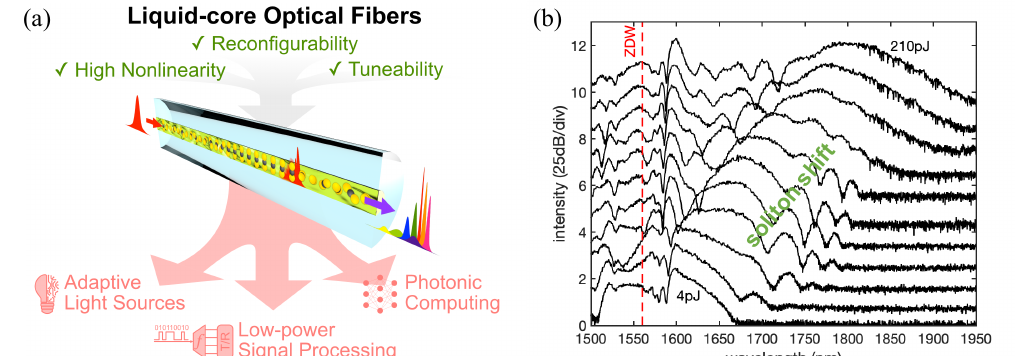
Fig. 1 (a) Advantages and application potential of liquid-core optical fibers. (b) Experimental showcase of pico- Joule-level soliton self-frequency shifting enabled by accurate design of the linear and nonlinear optical properties of straight-forward-to-fabricate step-index liquid-core